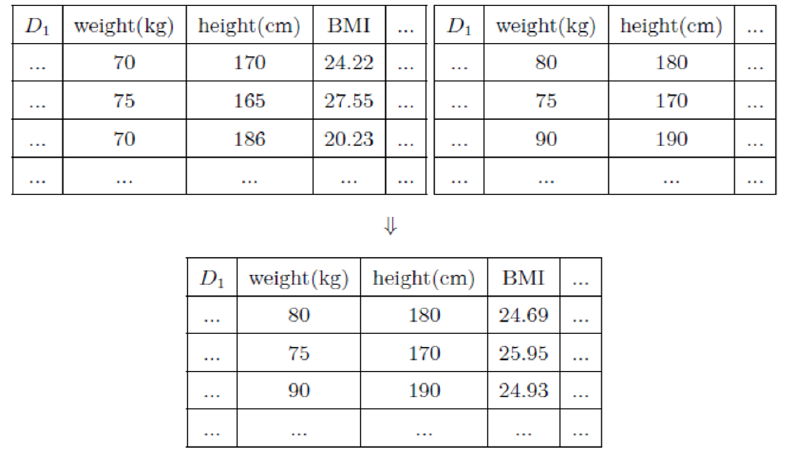
Figure 5. Three features end up in one table, with application of polynomials for dependent trait